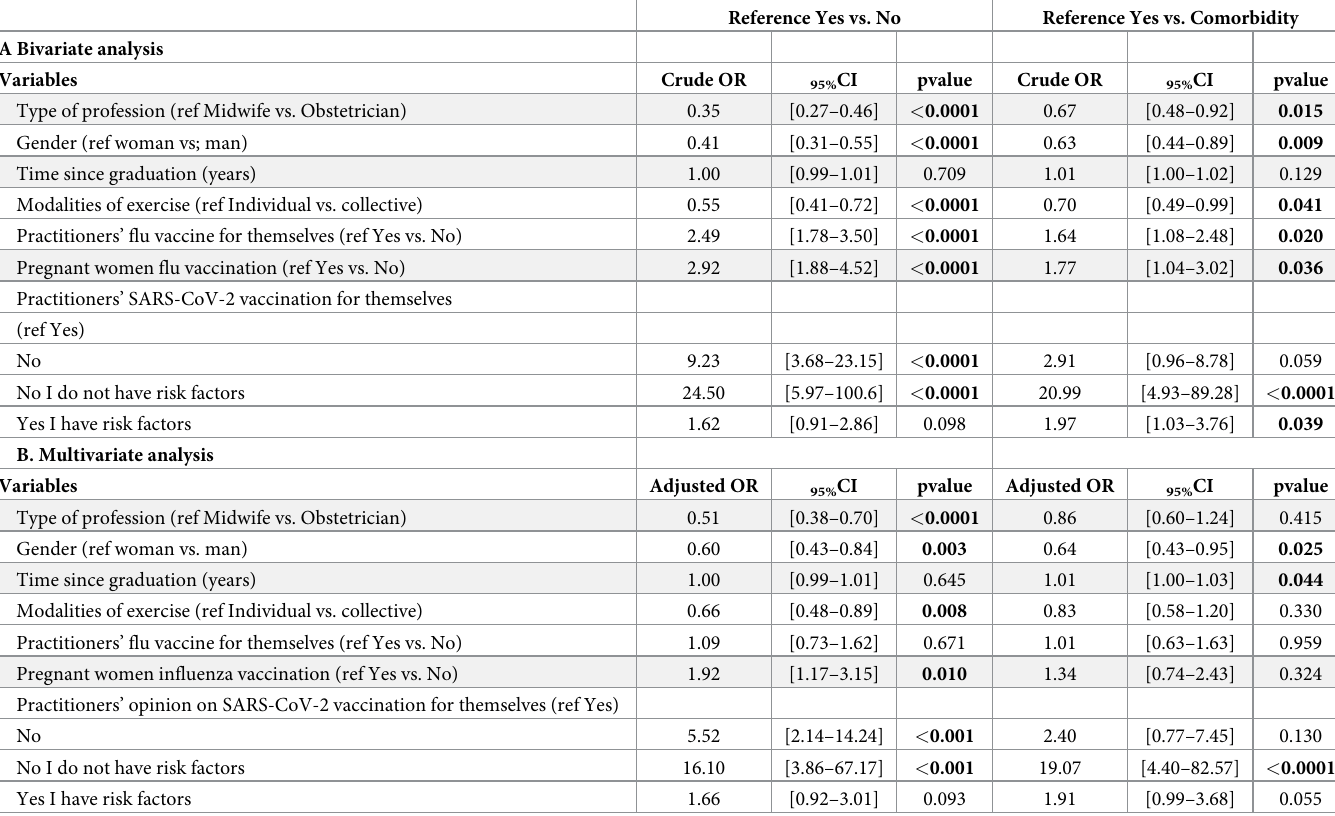
Table 3. a (bivariate analysis) and b (multivariate analysis). Association between intention to vaccinate the pregnant women and prenatal caregiver’s characteristics for the 1,347 responders (obstetrician and gynaecologists and